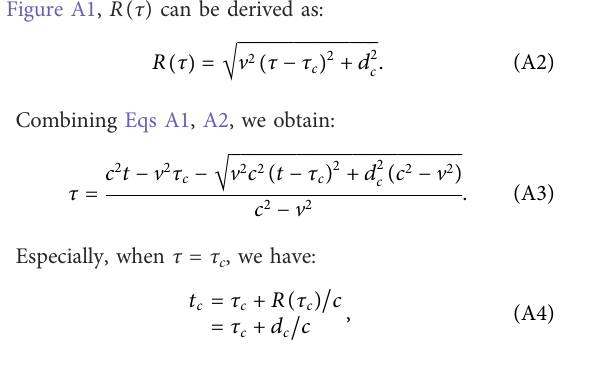
FIGURE A1 The trajectory of a tone source as it travels past the receiver node in a straight line atconstant velocity v . R gives the slant range between the receiver and the source. The distance from the receiver to the CPA is denoted by d c